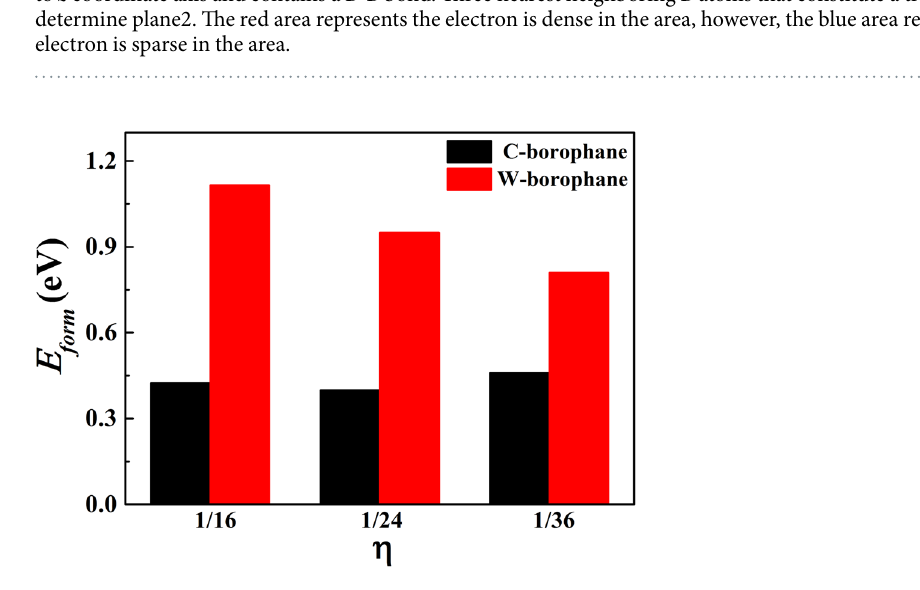
B , where N B is the per per